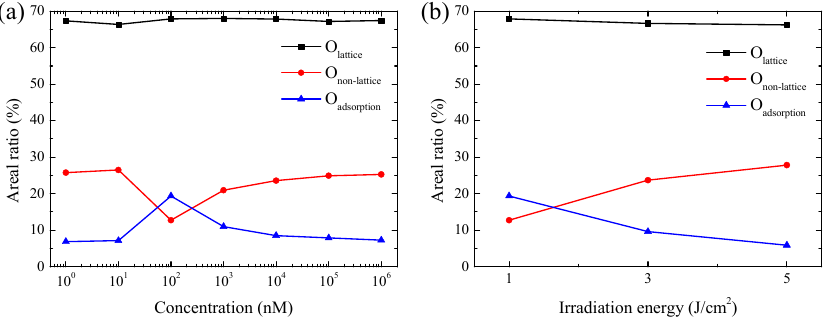
Figure 5. Areal ratio of O 1s in XPS with respect to ( a ) AgNO 3 concentration and ( b ) IPL irradiation energy.